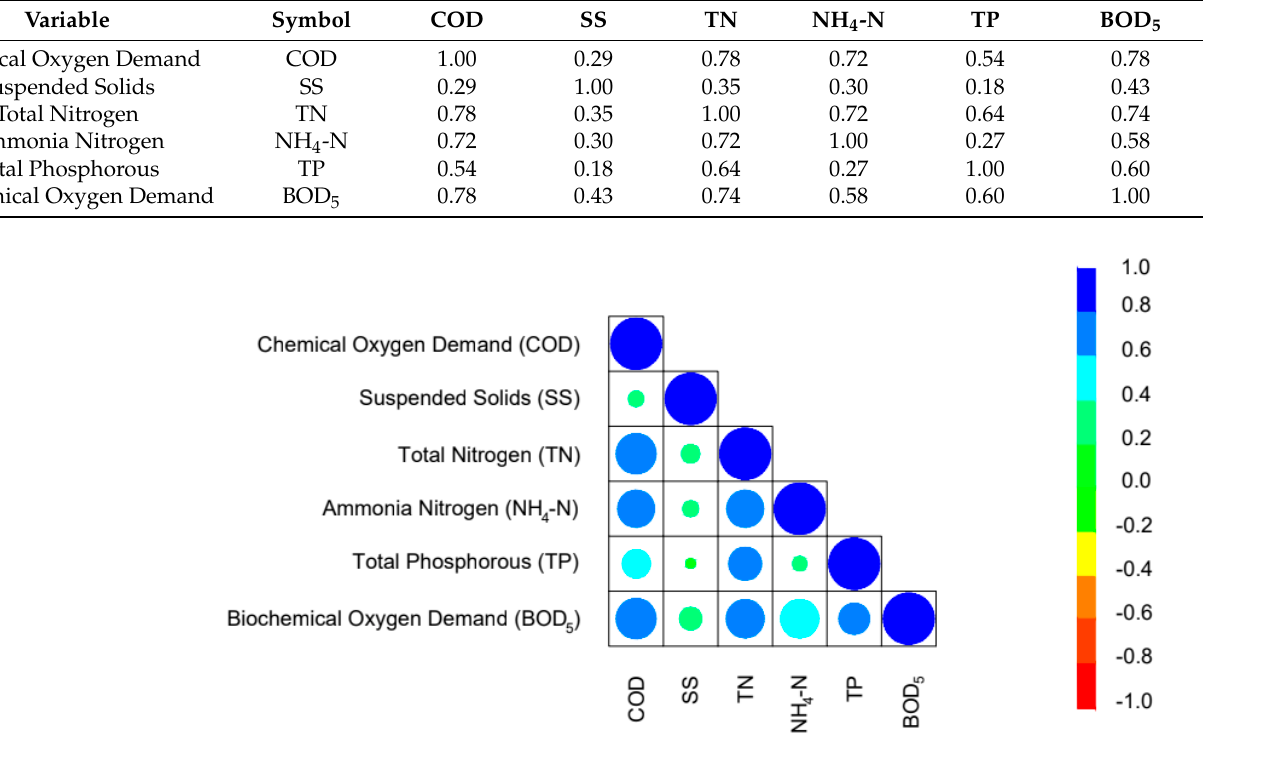
Figure 2. Pearson correlation coefficients between the examined variables.